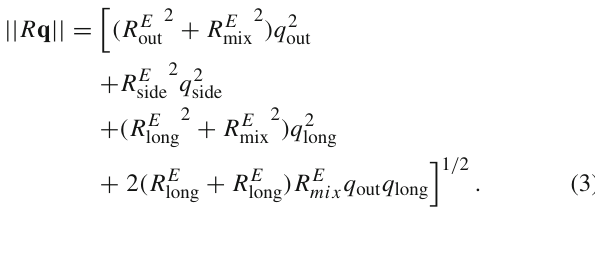
q components are taken into account for the fits. The corre- lation function is calculated for several bins in the average transverse momentum and rapidity of the pair y ππ